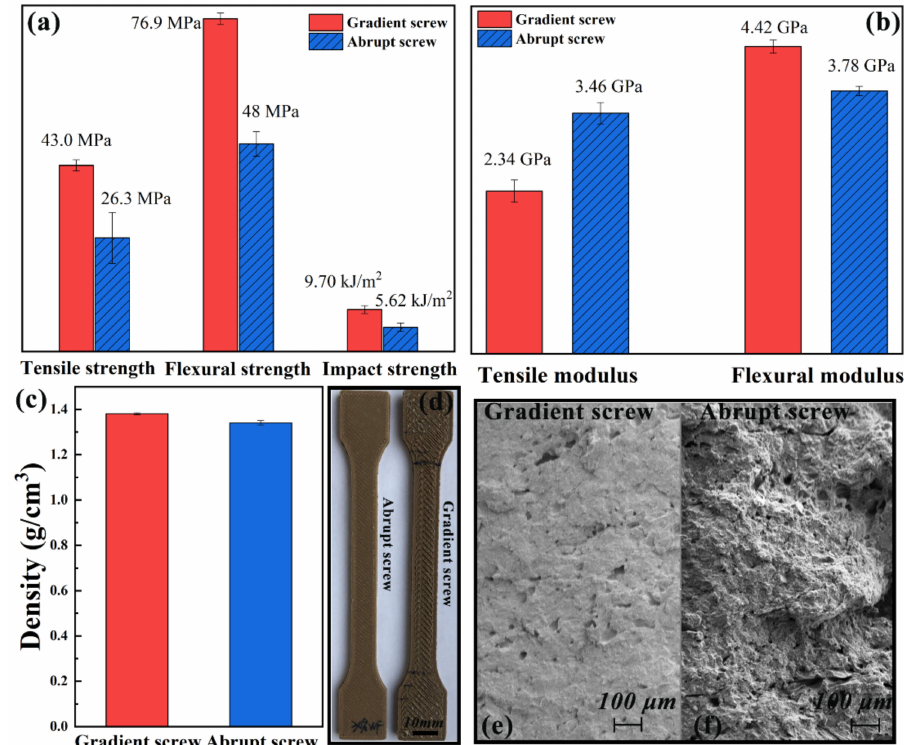
Figure 5. ( a ) Mechanical strength and ( b ) modulus, ( c ) density, ( d ) surface quality and ( e , f ) SEM images of samples printed by two kinds of